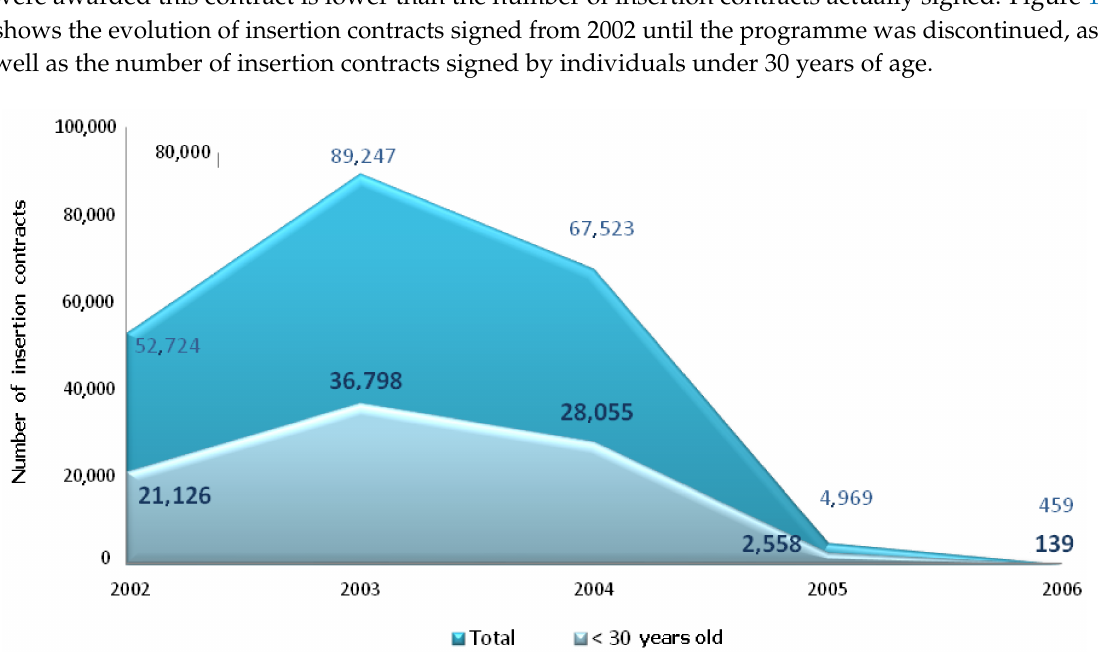
Figure 1. Total contracts of insertion (2002–2006). Source: Own elaboration from SEPE